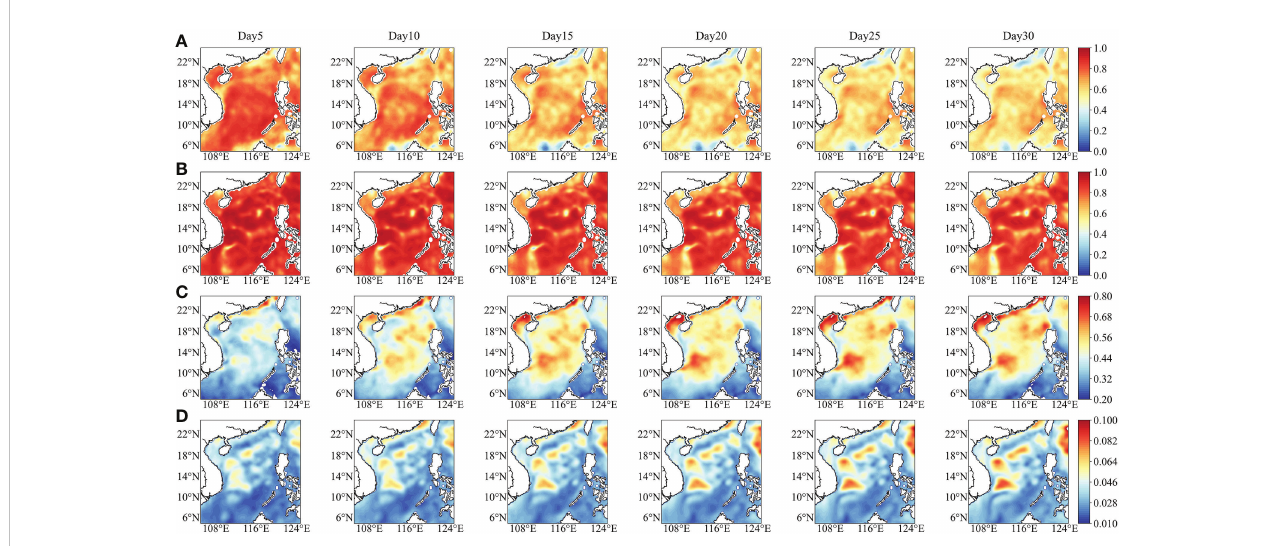
FIGURE 6 Spatial distribution maps of CC and RMSE on 5, 10, 15, 20, 25, and 30 days. (A) SSTA CC, (B) SSHA CC, (C) SSTA RMSE, unit: °C, (D) SSHA RMSE, unit: m.